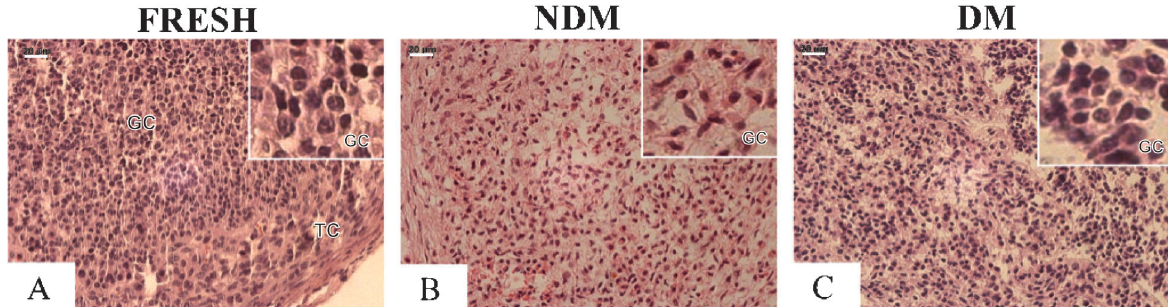
Figure 1. Morphological characteristics of granulosa cells (GC) and theca cells (TC) in A , fresh bovine ovarian follicle wall sections (FWS), FWS cultured in B , nondefined medium (NDM) or in C , defined medium (DM) after 48 h revealed by hematoxylin-eosin staining. Note the similar morphology between GC in Panels A and C and fibroblast-like GC in Panel B . The results of 24 h were similar to those observed at 48 h (data not shown). Bar=20 m m.